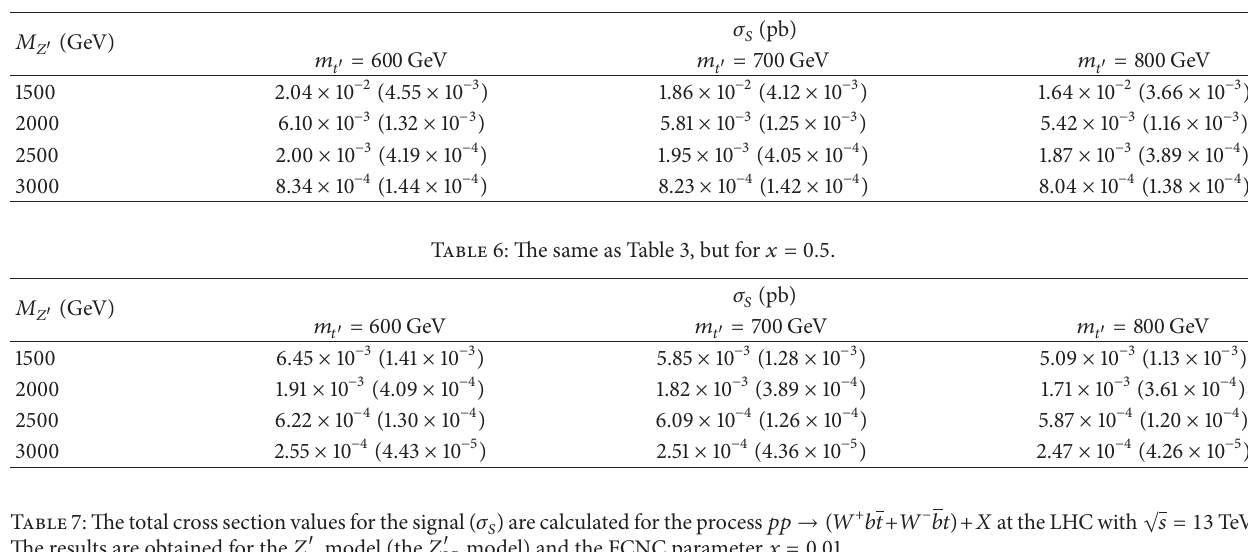
Table 5: The same as Table 3, but for 𝑥 = 0.1 .